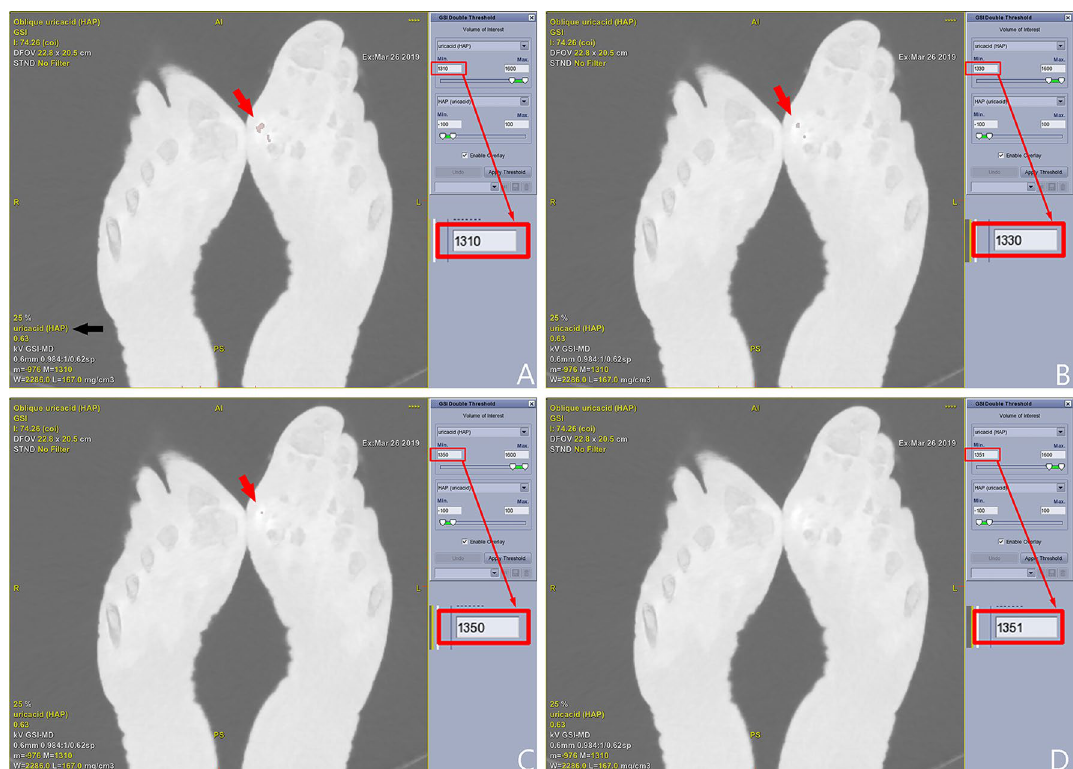
Figure 3. An example of obtaining MLLSV. The detection threshold of HAP (uricacid) map is set as − 100 ~ 100 mg/cm 3 . The lower limit of detection threshold (mg/cm 3 ) is adjusted on the uricacid (HAP) map. Multiple stained sites [red arrow in ( A )] were shown in the left first MTP joint with lower limit of 1310 mg/ cm 3 (red rectangle) of the uricacid (HAP) map [black arrow in ( A )]. The number of stained sites [arrow in ( B )] decreased at lower limit of 1330 mg/cm 3 [red rectangle in ( B )]. Only one stained site [arrow in ( C )] is visible with the lower limit of 1350 mg/cm 3 [red rectangle in ( C )]. The last stained site is not seen with lower limit of 1351 mg/cm 3 [red rectangle in ( D )]. MLLSV is thus 1350 mg/cm 3 for this case. MLLSV = maximum lower limit with stain visible. HAP (uricacid) = hydroxyapatite (uric acid), uricacid (HAP) = uric acid